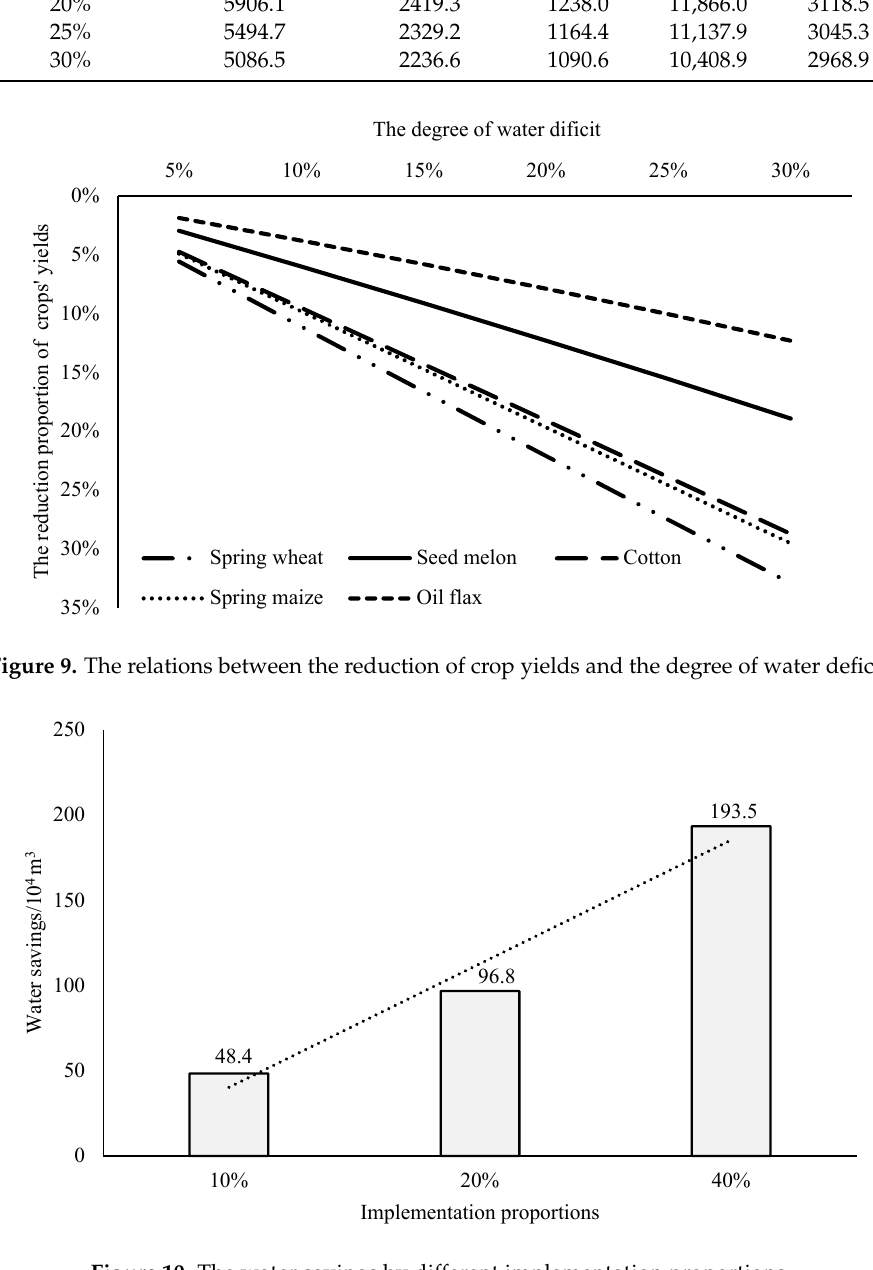
Figure 10. The water savings by different implementation proportions.